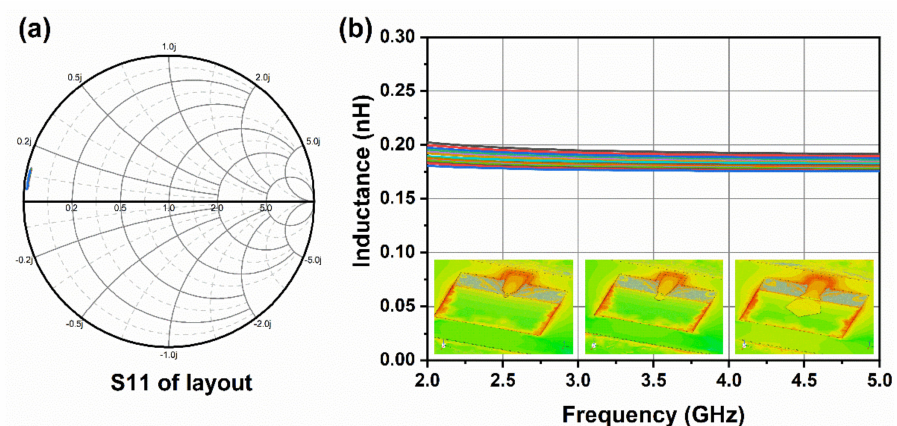
Figure 6. Simulation results of the EM model. ( a ) Smith charts of the simulated S11 of electrodes with different sizes. ( b ) Extracted inductances using the imaginary part of the simulated admittance with different sizes, and the embedded graphs are the simulated electric field plots of resonators with areas of 20 × 20 µ m 2 , 60 × 60 µ m 2 and 160 × 160 µ m 2 .